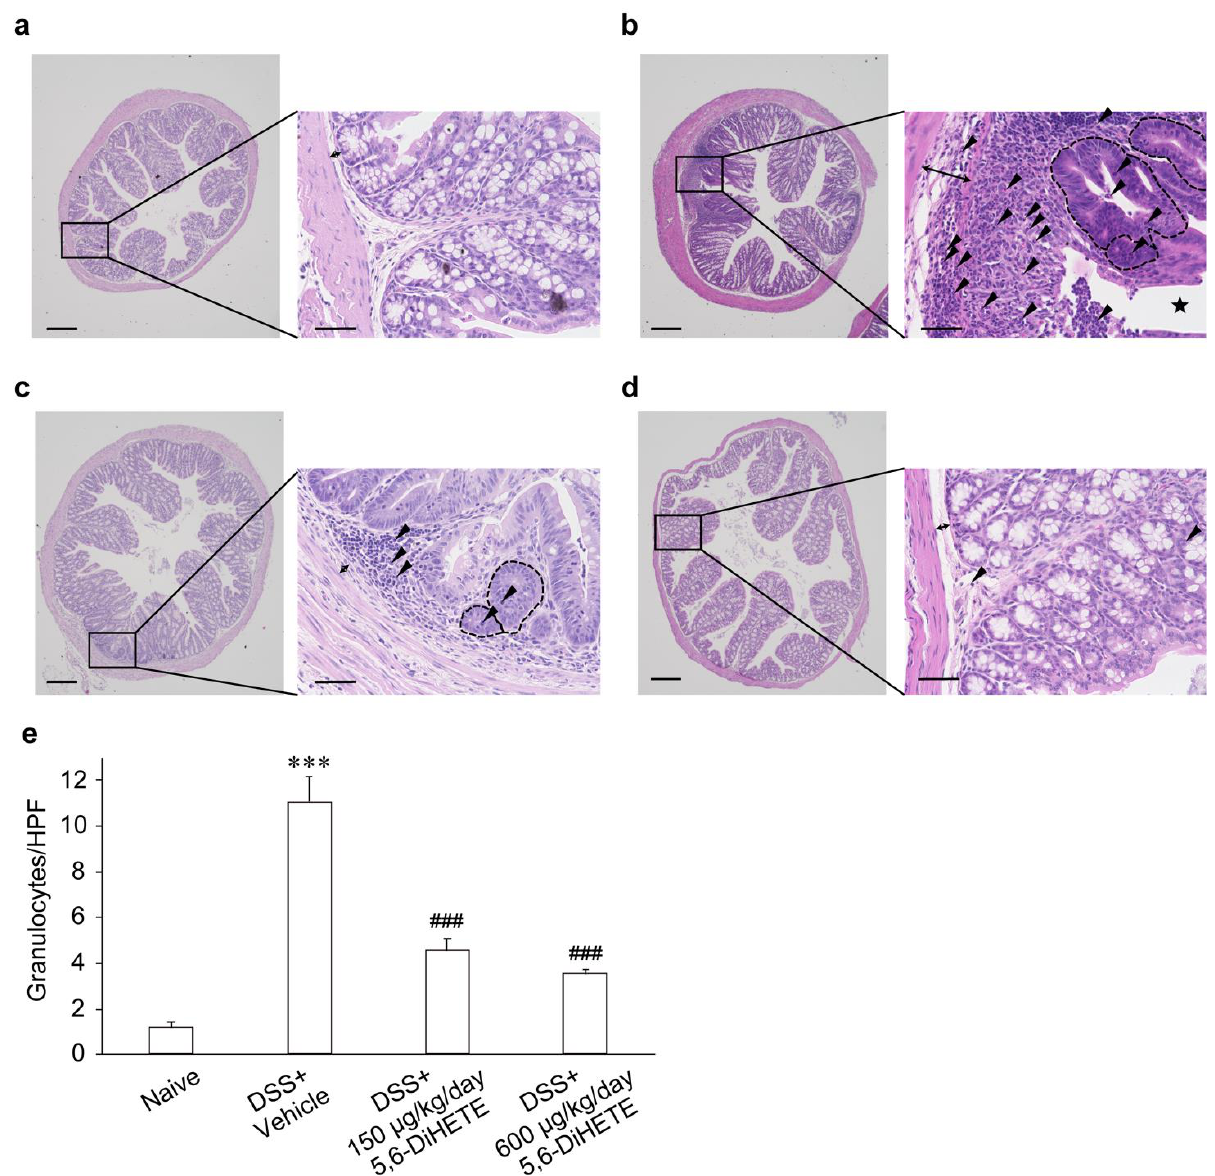
Figure 3. Effects of oral administration of 5,6-DiHETE on inflammation in colon on day 14. The sections of dissected colons on day14 were stained with hematoxylin and eosin. Representative images of ( a ) Naive (n = 5), ( b ) DSS + Vehicle (n = 8), ( c ) DSS + 5,6- DiHETE (150 μg/kg/day, n = 8) and ( d ) DSS + 5,6- DiHETE (600 μg/kg/day, n = 9) in low-power field (left panel, magnification 40×, scale bar = 2 50 μm) and high -power field (HPF, right panel, magnification 400×, scale bar = 50 μm). Double -headed arrows indicate the width of submucosa. Arrowheads indicate infiltrated granulocytes. Areas sur- rounded by dotted line indicate cryptal abscesses. Star shape indicates mucosal erosion. ( e ) The number of granulocytes in HPF (magnification 400×). Granulocytes were counted in randomly selected 25 fields for each tissue. Then, the mean value of them was adopted as the number of granulocytes in the tissue. Data are represented as mean ± SEM. *** p < 0.001 compared with Naive. ### p < 0.01 compared with DSS + Vehicle. Naive, non-treated healthy mice; DSS + Vehicle, vehicle- treated DSS colitis mice; DSS + 5,6- DiHETE (150 μg/kg/day), 150 μg/kg/day of 5,6 -DiHETE-treated DSS colitis mice; DSS + 5,6- DiHETE (600 μg/kg/day), 600 μg/kg/day of 5,6 -DiHETE-treated DSS colitis mice.